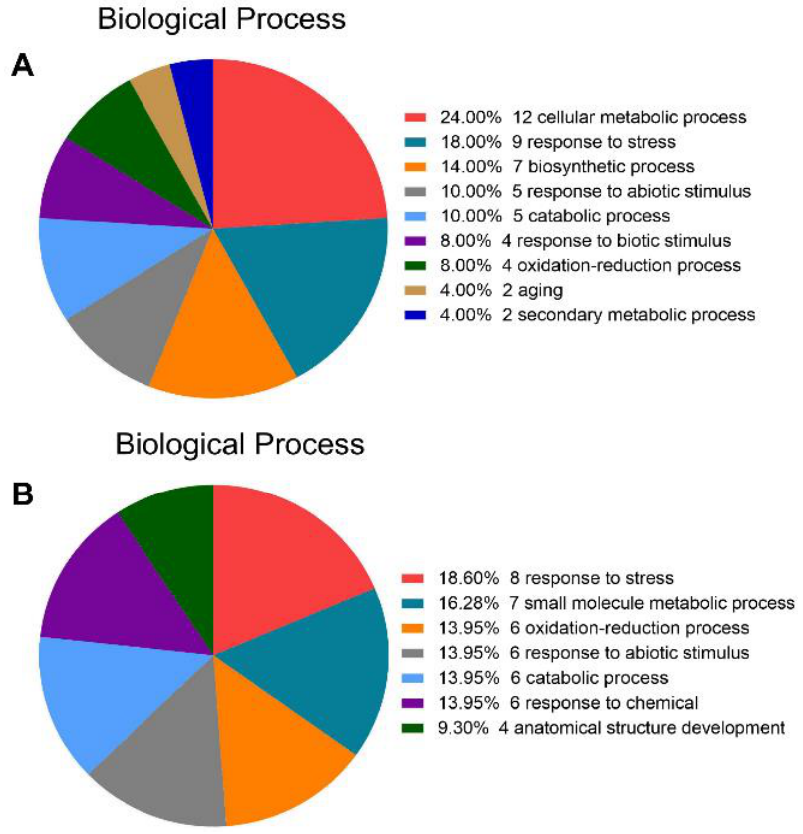
Figure 4. Functional annotation of different proteins under normal hydroponic conditions. ( A ) Bi- Functional annotation of different proteins under normal hydroponic ological processes of proteins identified in shoots. ( B ) Biological processes of proteins identified in roots.